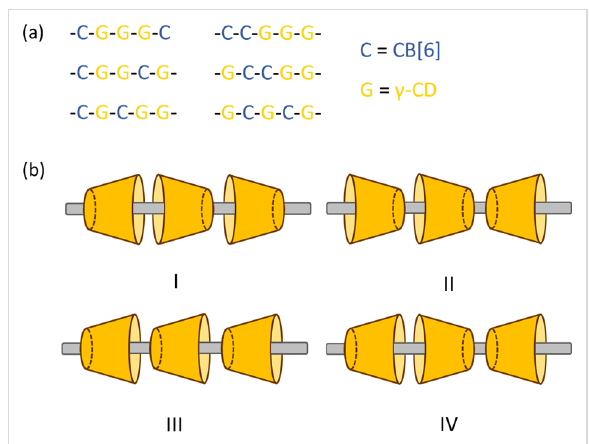
Figure 3: (a) All the possible sequences of a [6]rotaxane with two CB[6] and three γ -CD interlocked on an axle. Only the sequence on the top left was observed in 6R (with the orientation of the γ -CD disre- garded). (b) The four possible relative orientations of the three γ -CD in 6R